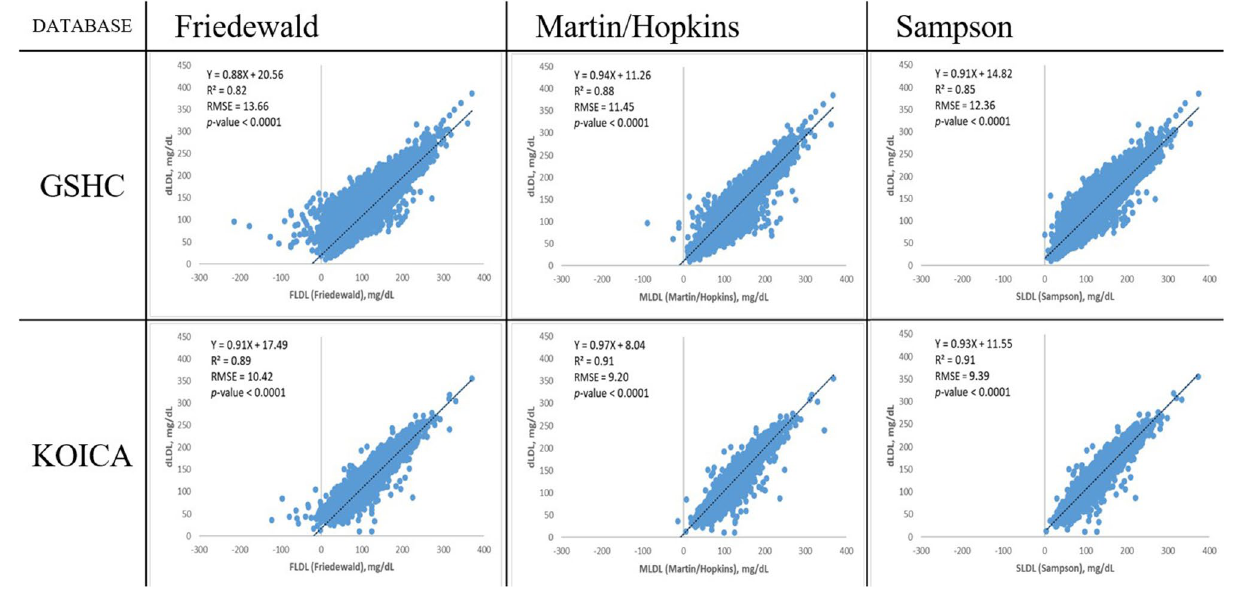
Figure 2. Scatter plots showing the correlation of direct LDL-C values with estimated LDL-C values using the Friedewald, Martin/Hopkins, and Sampson equations. RMSE root mean square error; GSHC Gangnam Severance Hospital Check-up; KOICA Korea Initiatives on Coronary Artery Calcification; LDL-C low-density lipoprotein cholesterol; dLDL direct LDL-C; TG TG: 16–2309 mg/dL; LDL-C: 11–356 mg/dL) the corresponding percentages were 1.42%, 21.4%, and 0.38%, respectively.